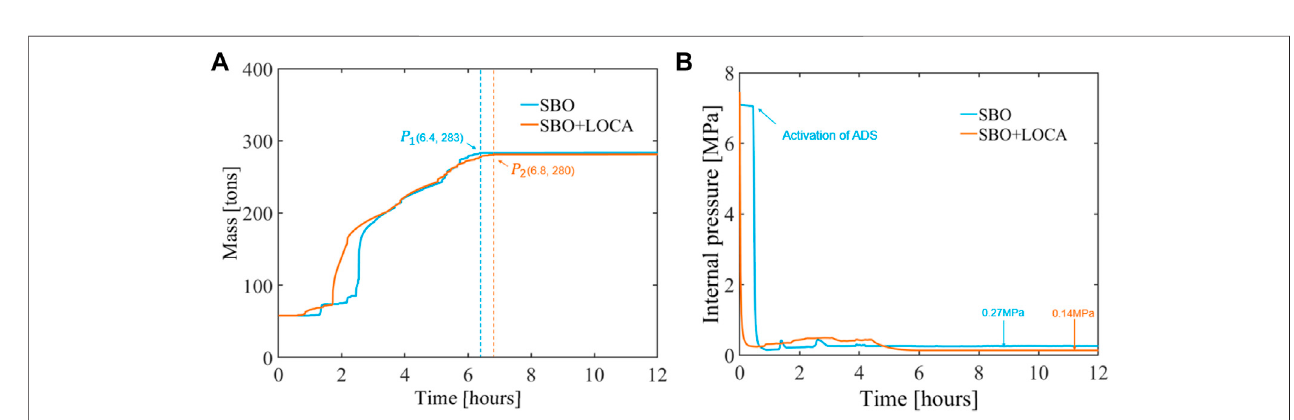
FIGURE 4 | (A) Evolution of total mass in the RPV lower head under SBO and SBO + LOCA scenarios. The total mass stabilizes at P 1 and P 2 in SBO and SBO + LOCA scenarios, respectively. (B) Evolution of RPV internal pressure under SBO and SBO + LOCA scenarios.